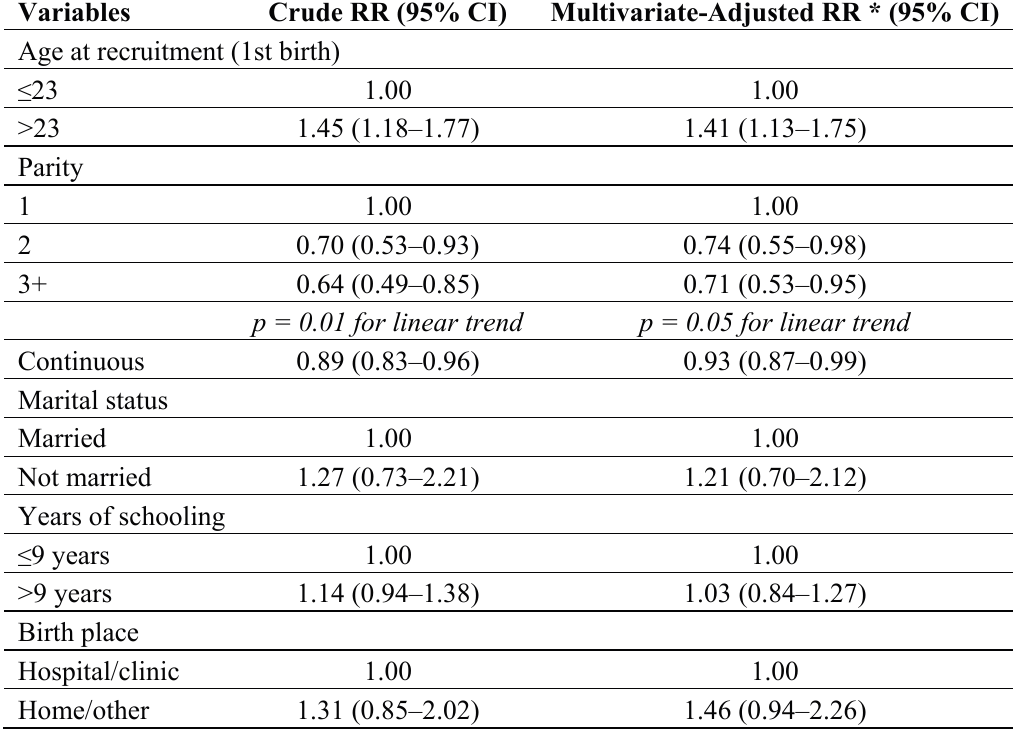
Table 2. Association between parity, age at first birth, and relative risk of death from non-Hodgkin’s lymphoma over a 32-year follow-up